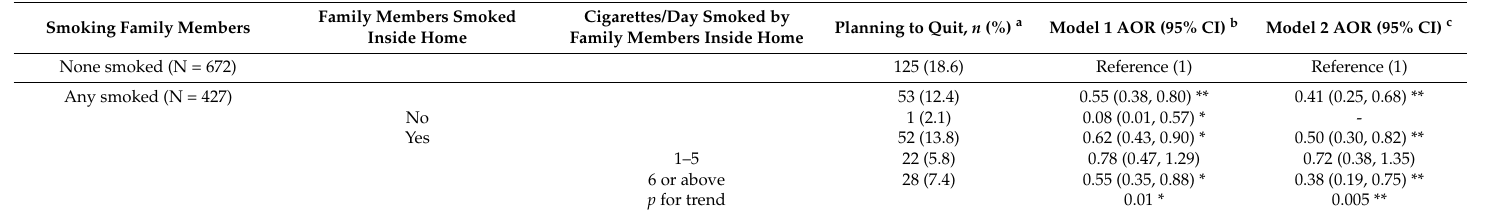
Table 1. Associations of living with smoker(s) and planning to quit smoking in 1099 current smokers at baseline.